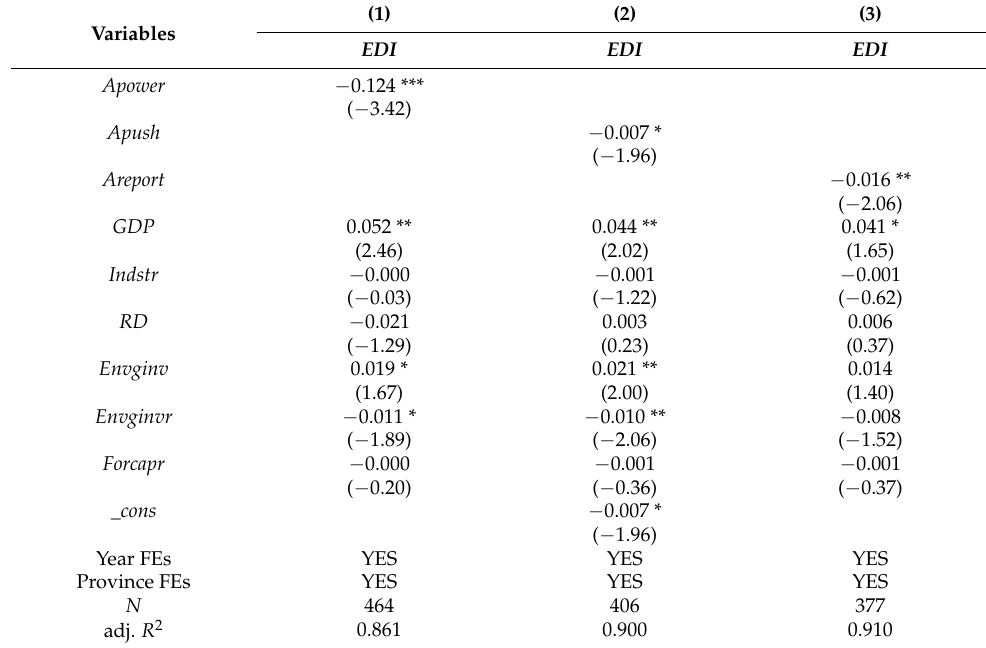
Table 5. The impact of government environmental auditing on environmental quality.